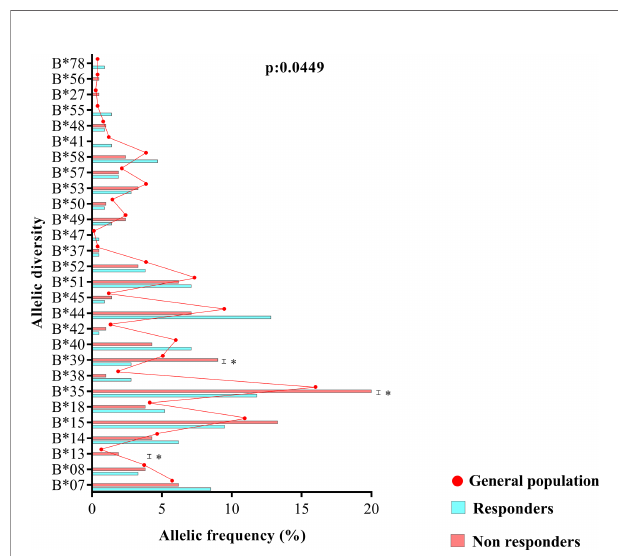
FIGURE 3 | Allele diversity of the HLA-B locus between treatment responders, treatment nonresponders and the entire study population (general population). The B*13, B*35 and B*39 alleles were more common in nonresponders (p = 0.0449).